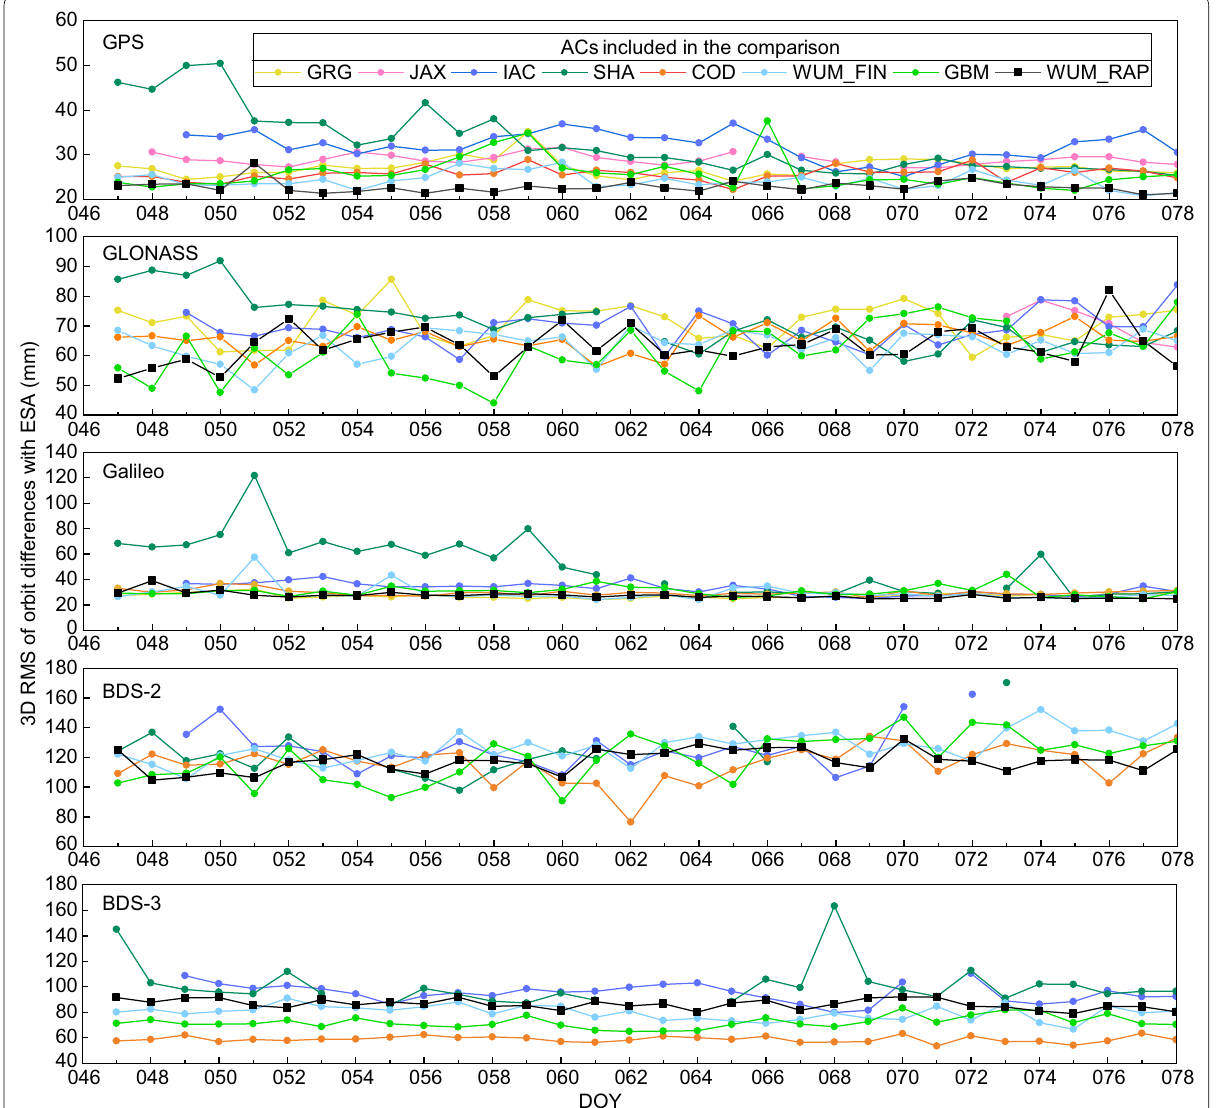
Fig. 4 3D RMS of orbit differences with respect to ESA MGEX products spanning from DOY 047 to DOY 078. “WUM_RAP” in black represents the orbit products provided in this